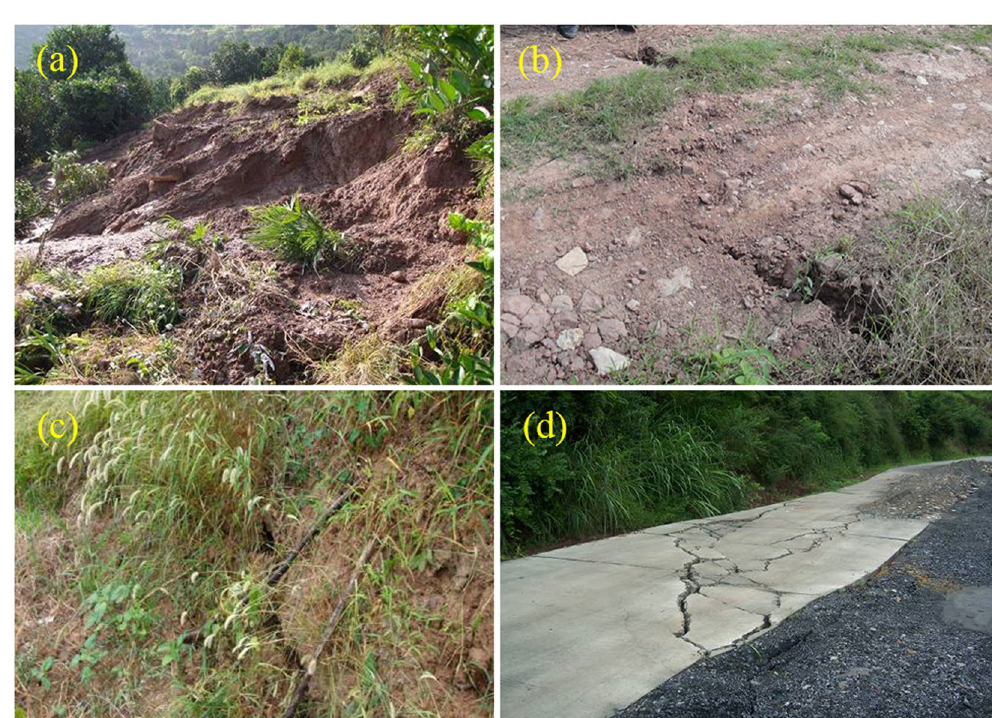
Figure 5. The deformation phenomena on the landslide mass: ( a ) slump of TH1, ( b ) crack of L2,( c ) crack of L4, and ( d ) crack of